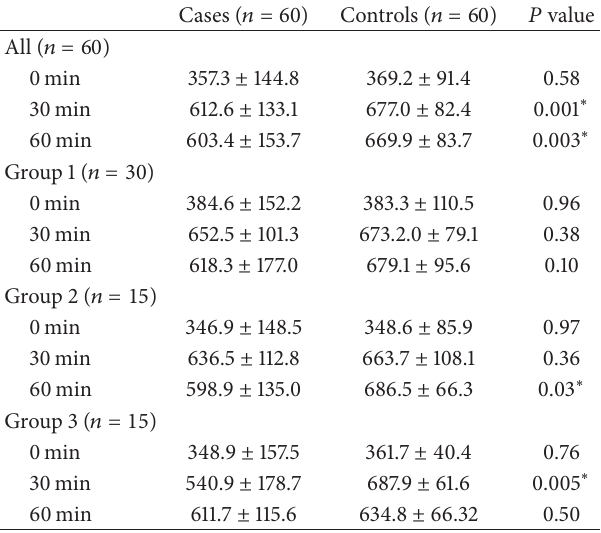
Table 2: Comparative cortisol values to cosyntropin before L-T4 replacement therapy between cases and their age-matched controls